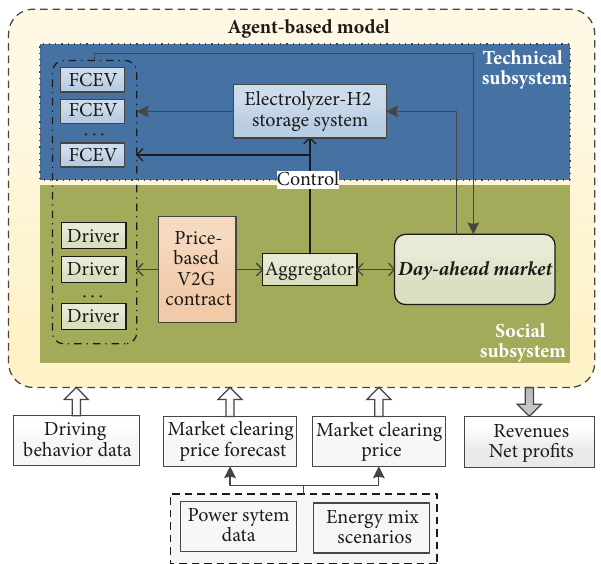
Figure 2: Agent-based model conceptualization: FCEVs in the day- ahead